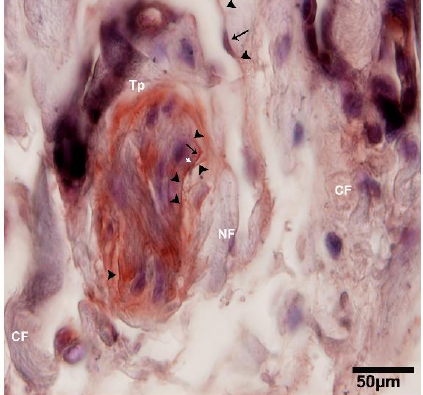
Figure 10. CD34-positive and α -SMA-positive for TCs and endothelial cells, where TCs surround the large duct within the connective tissue. At lower magnification image of IHC stained CD34-positive. Around the duct, Tps show a cluster deposition and form a triangular shape, along with the nerve fibers. The nuclei of the telocytes are stained blue and the podoms are indicated with the black arrows, while the prolongations of cells are shown with arrowheads and the junctions between two Tps are indicated with the white arrow. NF, nerve fibers; CF, collagen fibers; Tp, telopodes. Scale bar = 50 µm.